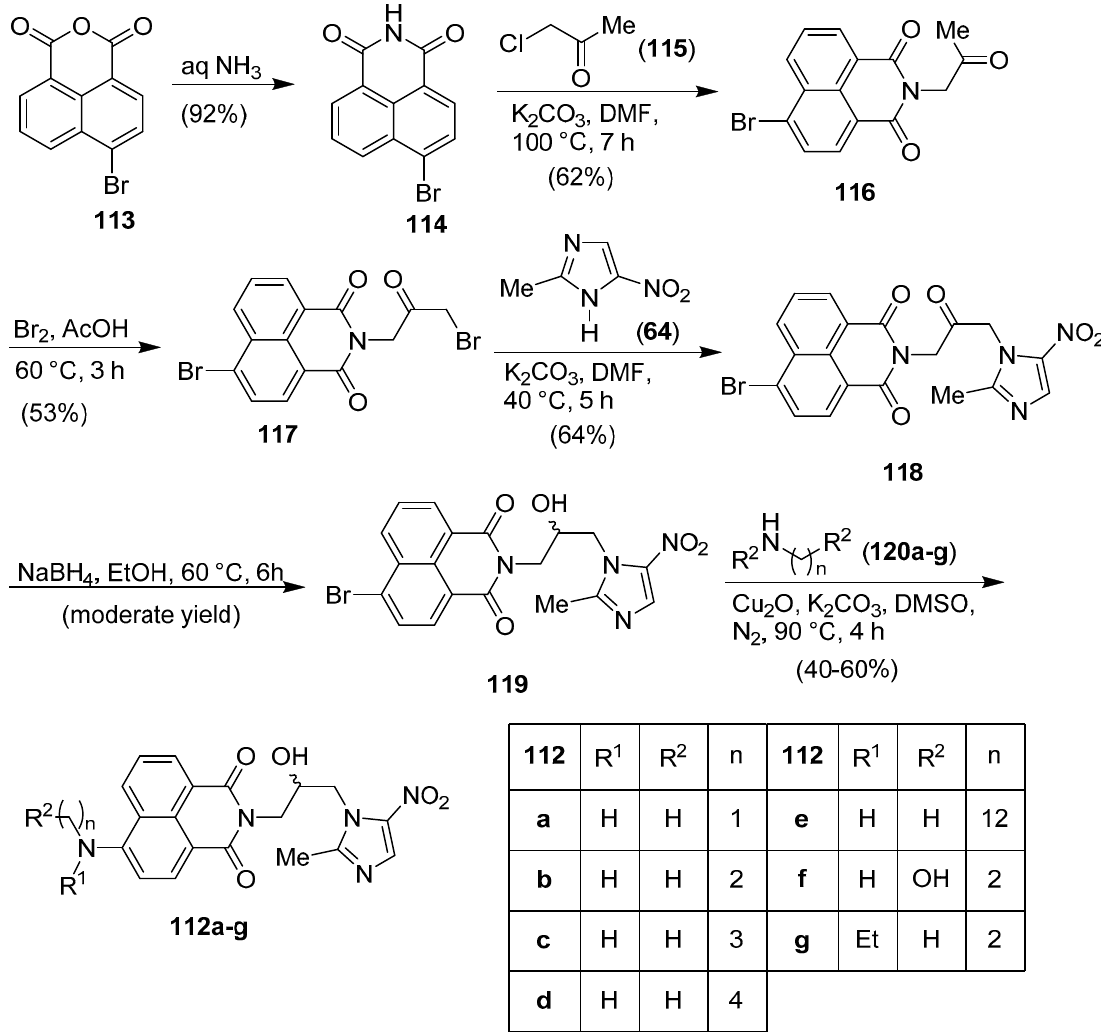
Scheme 21. Synthesis of naphthalimide-derived metronidazoles